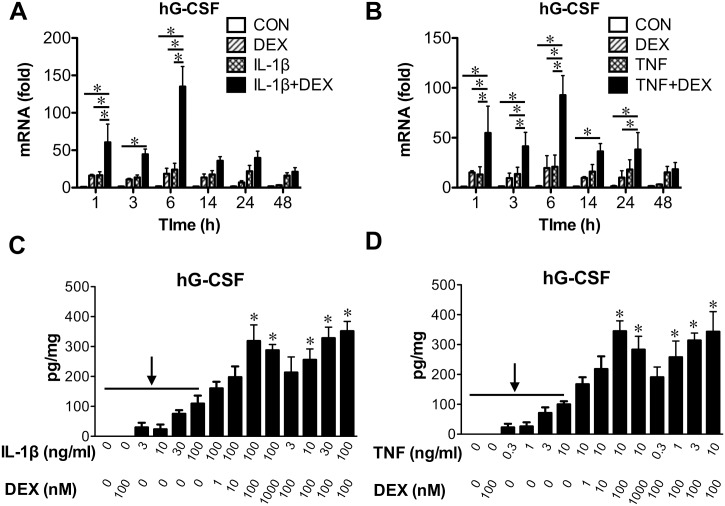
DEX and proinflammatory molecules synergistically induced G-CSF.(A) Time course experiment determining IL-1β (10 ng/ml) ± DEX (100 nM) induction of G-CSF mRNA in the immortalized human bronchial epithelial cell line BEAS 2B. Cells were treated in cell culture media supplemented with charcoal-stripped FBS that was devoid of endogenous glucocorticoids. Levels of mRNAs were quantified using realtime RT-PCR and normalized to the level of the housekeeping gene RPLP0. ✽, significantly different, two-way ANOVA followed by Bonferroni post-hoc tests. P<0.05 (N = 6–10). (B) Time course experiment as in (A) using TNF (1 ng/ml) ± DEX (100 nM). ✽, significantly different, two-way ANOVA followed by Bonferroni post-hoc tests. P<0.05 (N = 6–10). (C) DEX (100 nM, 48 h) enhanced IL-1β (3, 10, 30, and 100 ng/ml, 48 h) induction of G-CSF protein in BEAS 2B cell culture supernatant, which was confirmed using various doses of DEX (1, 10, 100, and 1000 nM) with 100 ng/ml IL-1β. ✽, significantly different from the groups indicated by the arrow, one-way ANOVA followed by Newman-Keuls post-hoc tests. P<0.05 (N = 3). (D) Results from dose-response experiments as in (C) using DEX (100 nM) and TNF (0.3, 1, 3, and 10 ng/ml). When using various doses of DEX, TNF was 10 ng/ml. ✽, significantly different from the groups indicated by the arrow, one-way ANOVA followed by Newman-Keuls post-hoc tests. P<0.05 (N = 3).